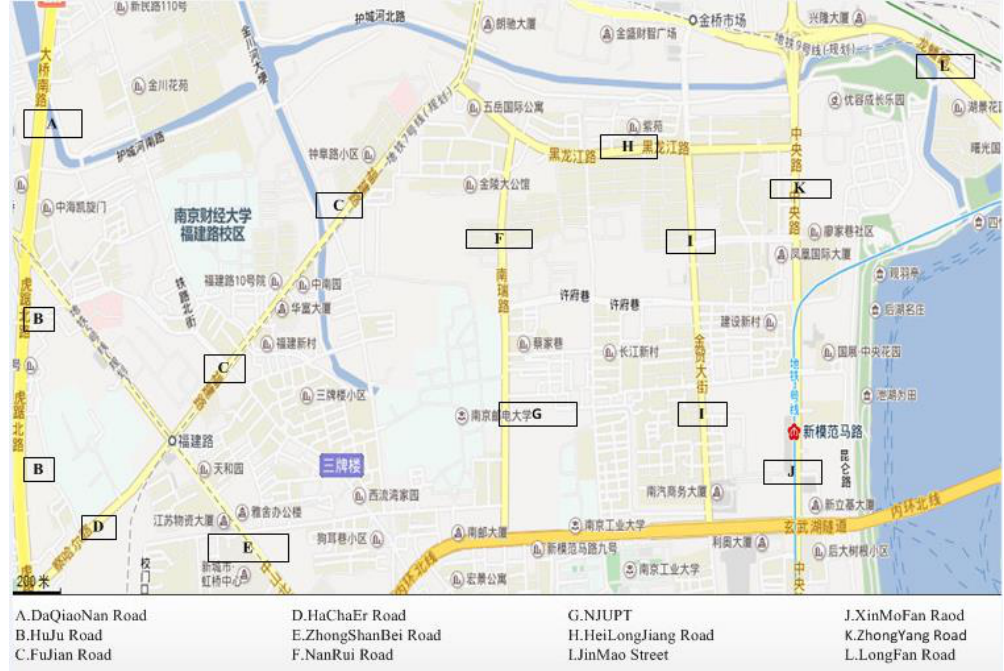
Figure 1. Nanjing transport network area in its geographical context.